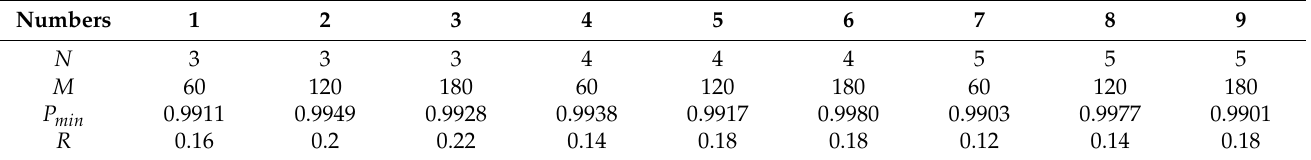
Table 3. Critical values of fragmentation effectiveness under different conditions.